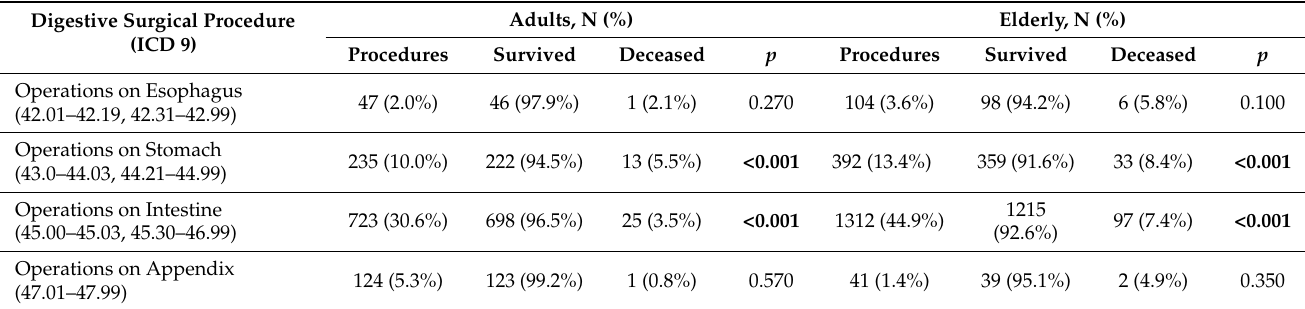
Table 1. Characteristics of emergency-admitted patients with the primary diagnosis of paralytic ileus. Data are stratified according to surgical procedure (NIS